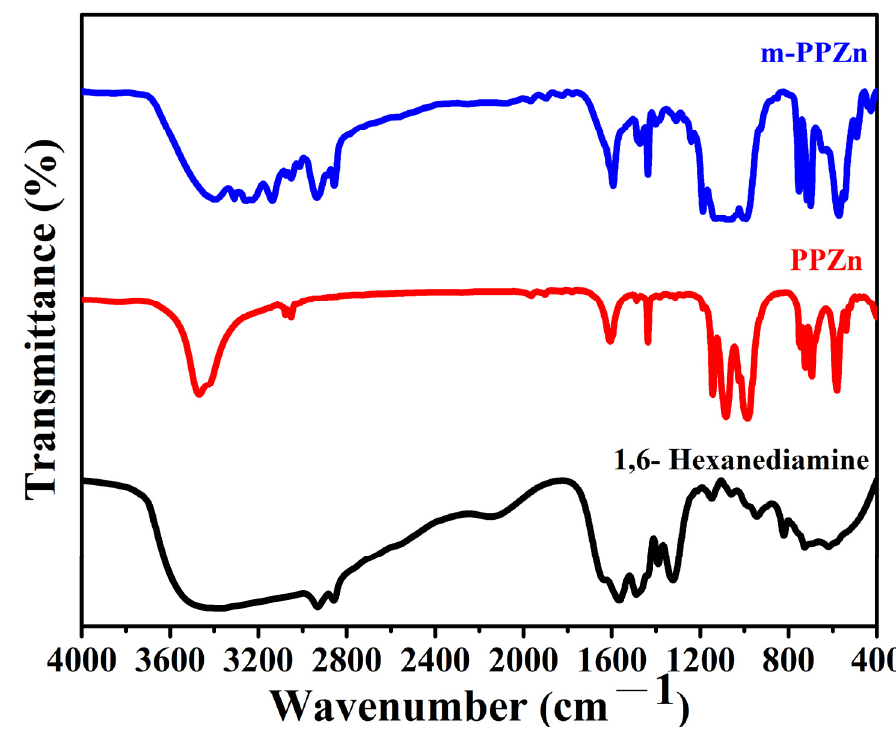
Figure 1. FTIR spectra of the PPZn, 1,6-hexanediamine and m-PPZn.